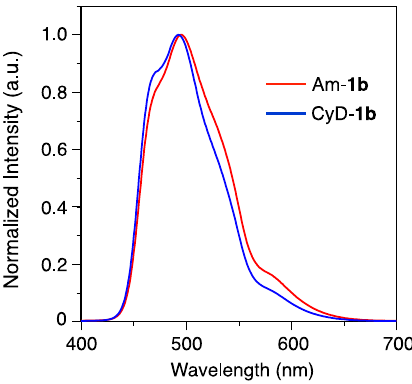
Figure 3. Fluorescence spectra of Am- 1b ( λ ex = 364 nm) and CyD- 1b ( λ ex = 362 nm) in THF at room temperature. [Glucose unit] = 1.0 × 10 − 5 M.